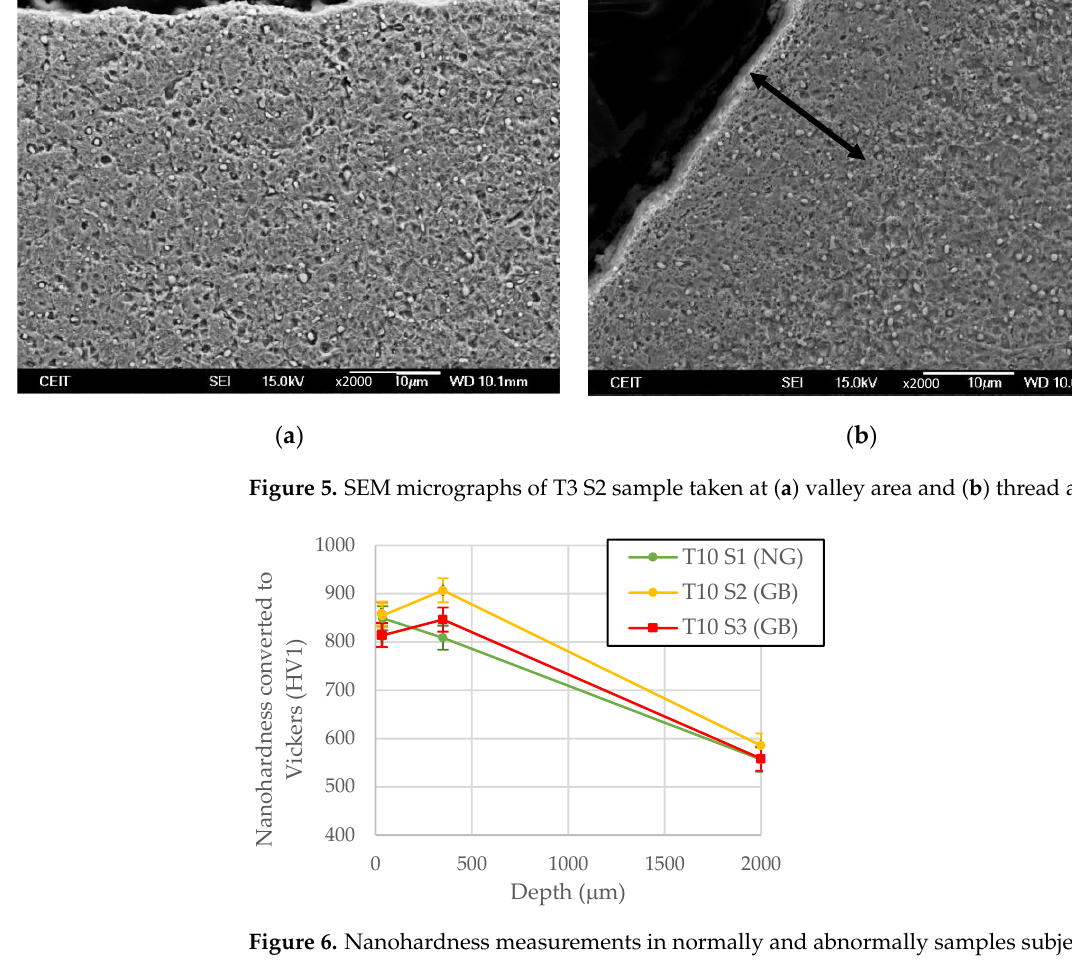
Figure 6. Nanohardness measurements in normally and abnormally samples subjected to T10 heat treatment. The value of the hardness shown in the surface is the average value of the matrix of 20 × 20 indentations with a spacing of 3 µ m and with the first line aiming at 3 µ m from the surface. A summary of the destructive test (DT) measurement data is shown in Table 1. Table 1 . Summary of destructive test (DT) measurements .